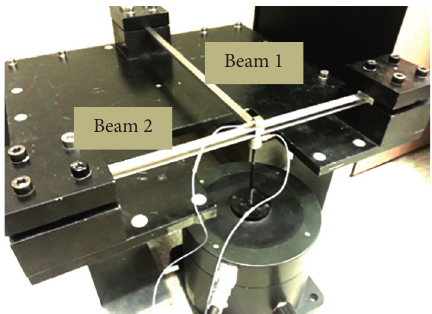
Figure 11: Experimental device for nonlinear beam structure [101].